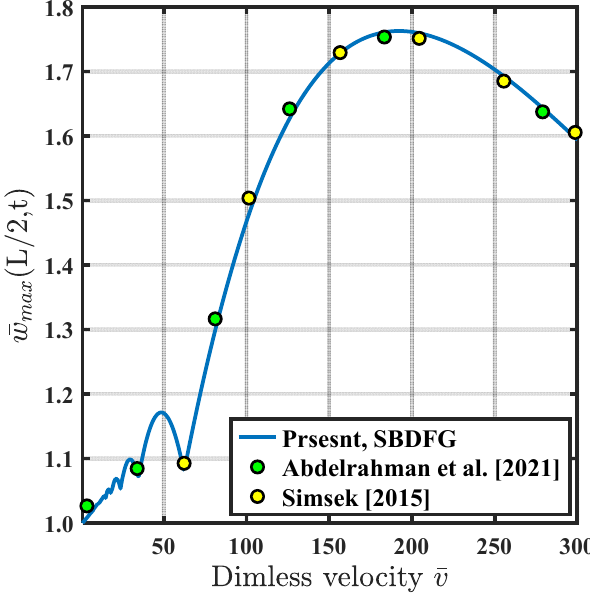
Figure 3. The variation in the dynamic deflection at the center of the beam vs. moving load velocity.